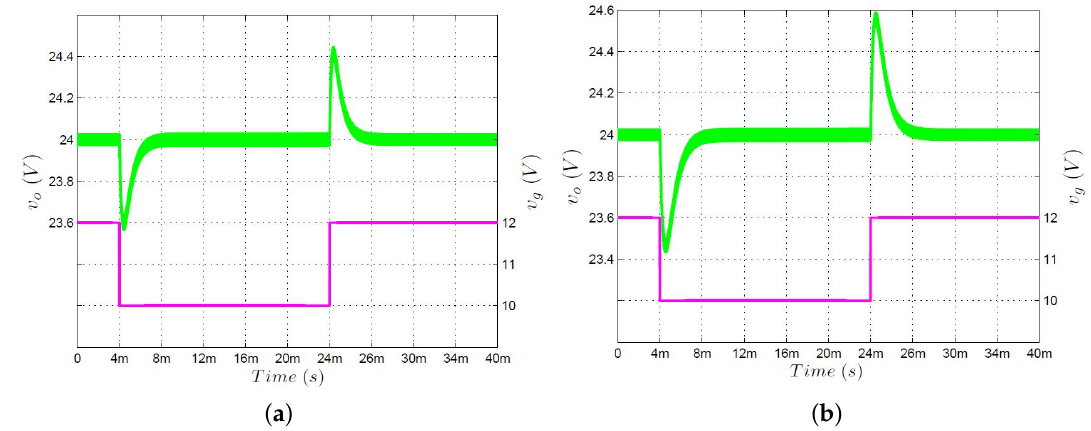
Figure 9. Simulated response of the boost converter under input voltage transients of 2 V with the LMI-Fuzzy controller ( F LMI − Fuzzy ) and LMI robust Controller ( F LMI ). ( a ) Voltage response v o with F LMI − Fuzzy . ( b ) Voltage response v o with F LMI